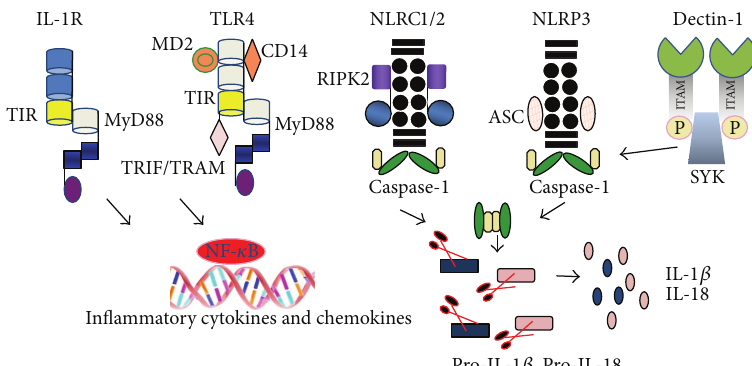
Figure 1: An integrative overview of intracellular signaling pathways by the IL-1R, TLRs, NLRs, and CLRs upon an innate immune response to microbial infection or cell death. Upon binding of PAMPs, DAMPs, or cytokines (IL-1 𝛼 or IL-1 𝛽 ) the recruitment and assembly of high oligomeric platforms containing one more subunits of receptors, adaptors, inhibitors, ubiquitin ligase, and an initiator caspases (caspase-1, -8, or -5) occur. Following phosphorylation, ubiquitination, and degradation, certain components of each platform and an inflammatory signaling pathway are triggered. TLR and IL-1R receptor platforms recruit and activate MyD88 protein via intracellular Toll/IL-1R homology (TIR) domain. TIR domain interacts with MyD88, TIRAP/Mal, or TRIF/TRAM, which are proteins sharing a similar TIR domain. These proteins interact with the death domain of serine/threonine kinase (IRAK) family and IRAKs, which in turn promote the phosphorylation and activation the interferon regulatory factors (IRF1, 3, 5, 7), leading to the production of type I interferons (IFN- 𝛼 and - 𝛽 ) in a cell-type- specific manner. IRAKs also cause the phosphorylation and activation of TAK1/TAB2/3 which in turn promote the phosphorylation of the inhibitor of NF- 𝜅 B (IKK subunits 𝛼 , 𝛽 and 𝛾 ) and thereby NF- 𝜅 B activation. The different (NOD)-like receptors (NLRs), for example, NLRP3, interact with specific PAMPs or DAMPs to gather an inflammasome platform, via the ASC adaptor, which recruits and activates caspase-1, which in turn cleaves and releases IL-1 𝛽 and IL-18. Some myeloid C-type lectin receptors (CLRs), for example, Dectin-1 recruits Syk through a phosphotyrosine in the hemITAM motif. Syk induces the activation of the NALP3 inflammasome, leading to the processing of pro-IL-1 𝛽 . See text for further details.